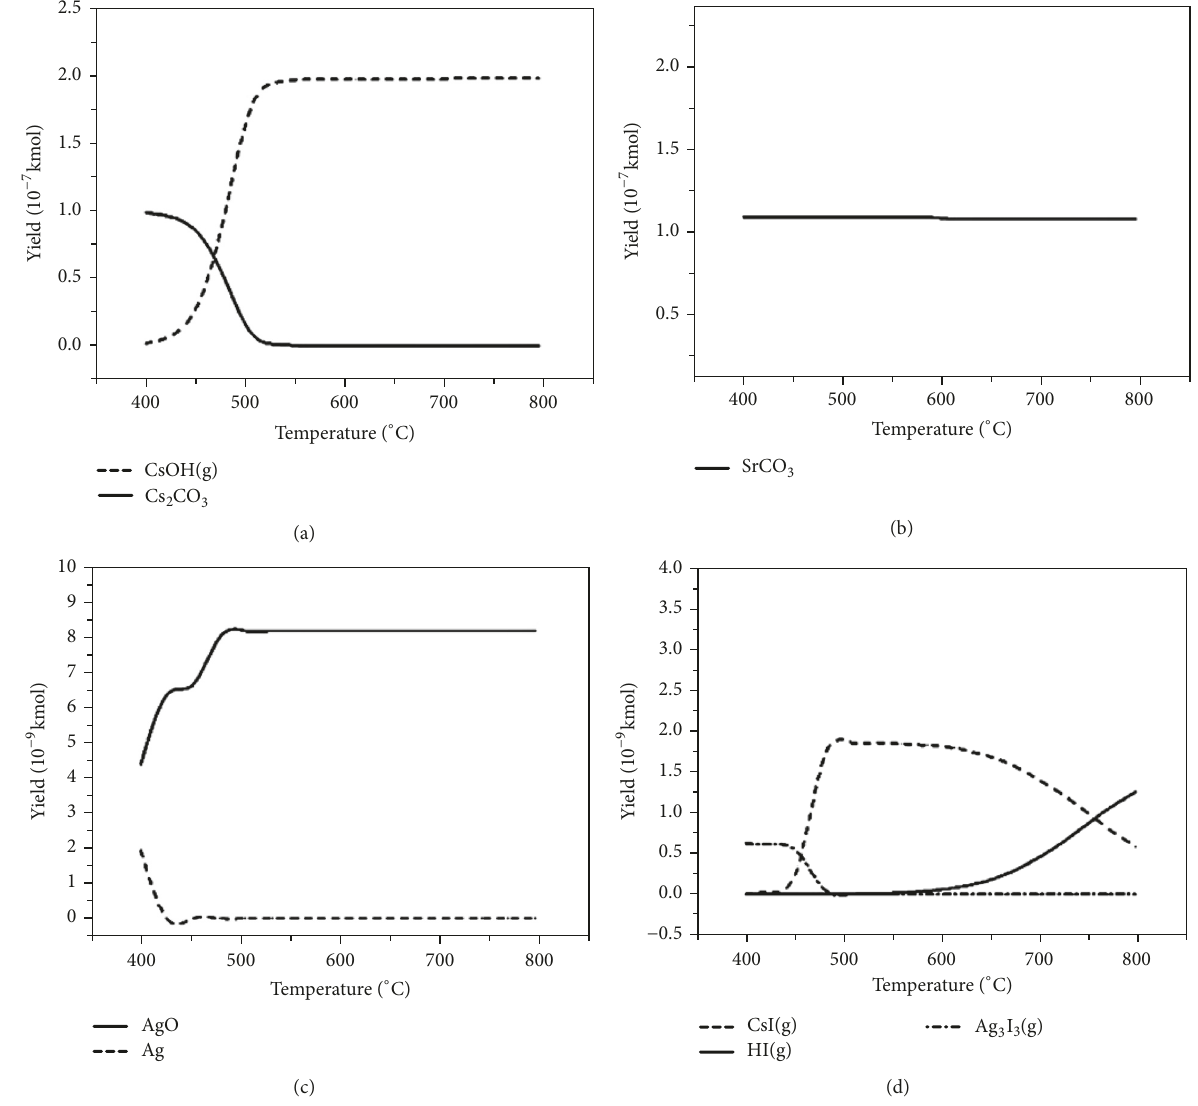
Figure 8: Variations in the chemical forms of 24h after water ingress accident: (a) Cs, (b) Sr, (c) Ag, and (d)